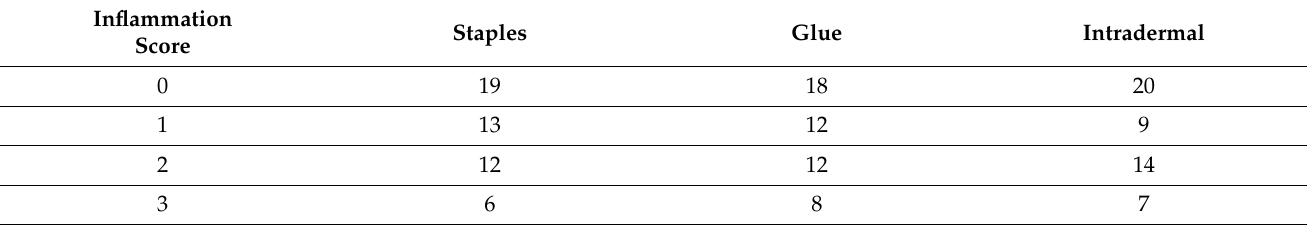
Table 3. Incidence of each inflammation score for each